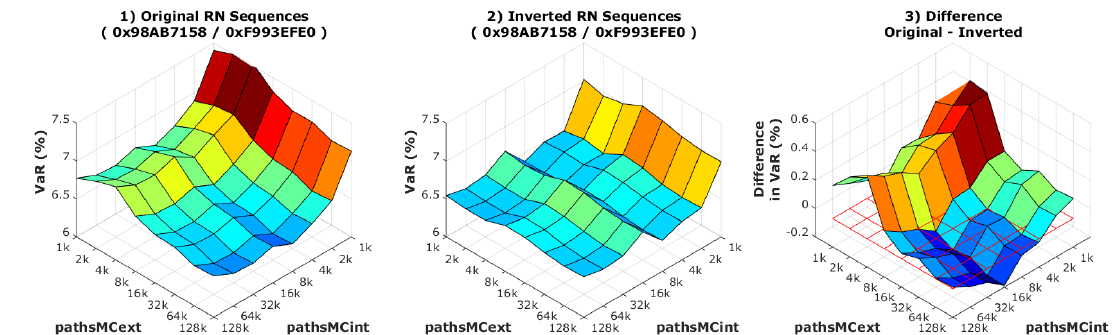
Figure 7. VaR variations (for the same kernel) when the RN sequences are given in different order. (Plot 1) shows the original result, with Mersenne twister (MT) seeds (0 x 98 AB 7158/0 xF 993 EFE 0); (Plot 2) uses the same set of RNs (same seeds), but reorganized in memory in the opposite (inverted) order, from last to first; (Plot 3) shows the difference between both plots (the red grid is placed at 0